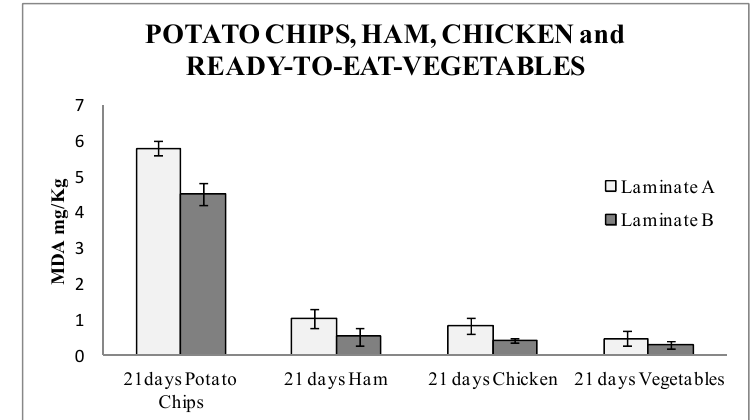
Figure 4. TBARS results expressed as mg of MDA per kg of potato chips, ham, chicken, and ready-to-eat-vegetables packaged in laminate A (control) and laminate B (actives with nanoselenium particles) for 21 days.